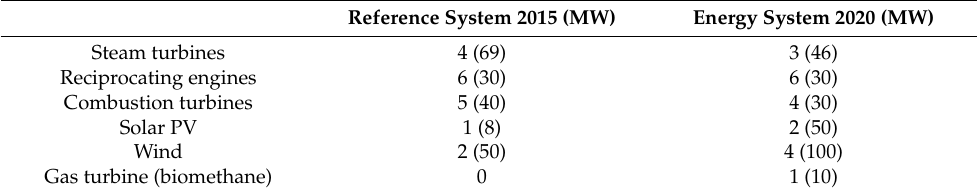
Table 2. Number of generator units and the total installed capacities in 2015 and 2020